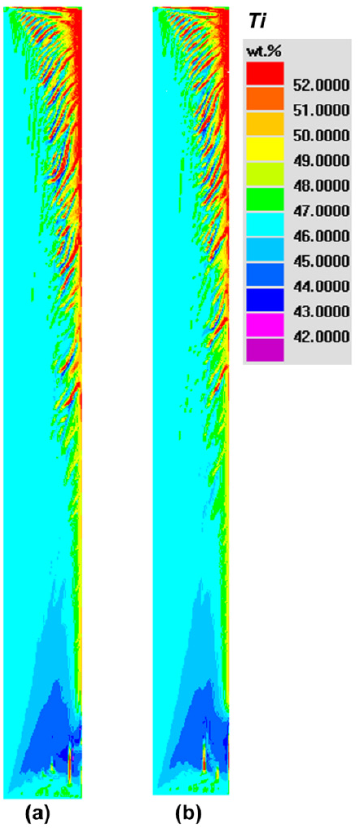
Figure 11. The effect of cooling rate on the final macrosegregation of Ti. The interface heat-transfer coefficients between mold and melt are increased to be 2500 ( a ) and 3000 W m − 2 K − 1 ( b ), respectively.